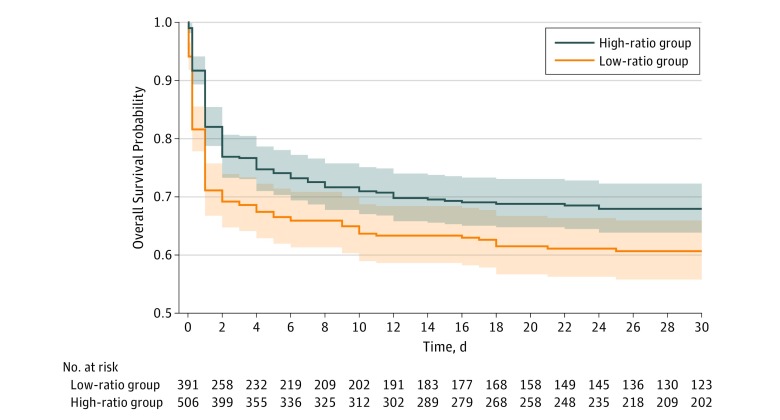
Kaplan-Meier Survival Curves for the Probability of Survival During the First 30 Days Following Hospital Admission According to the Transfusion Ratio Used During the First 6 HoursHigh ratio indicates a fresh frozen plasma to packed red blood cells ratio of more than 1:1.5; low ratio, 1:1.5 or less. Shaded areas around curves represent 95% CIs. Log-rank test for 30-day survival, P = .006.